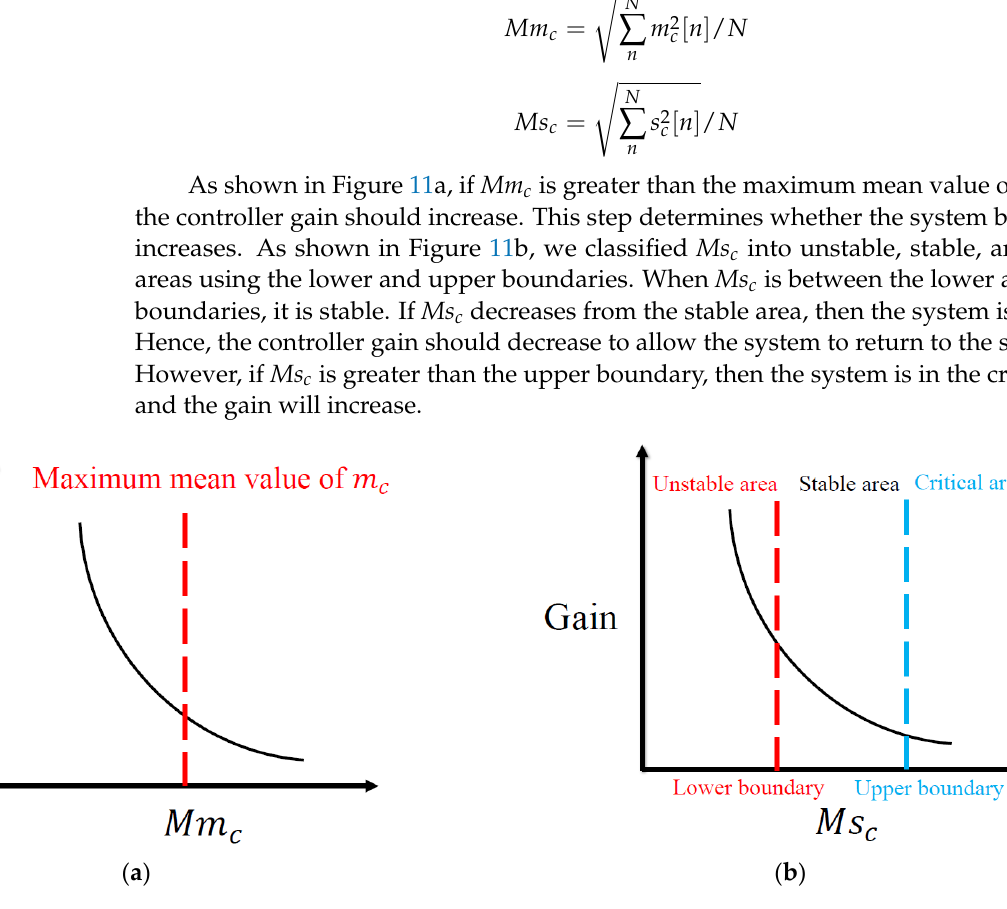
Figure 11. Relationship between ( a ) 𝑀𝑚 𝑐 and gain and ( b ) 𝑀𝑠 𝑐 and gain. Using these criteria, the controller gains can be easily obtained and the system op- timized using the feedback values of currents. A flowchart of the proposed strategy is presented in Figure